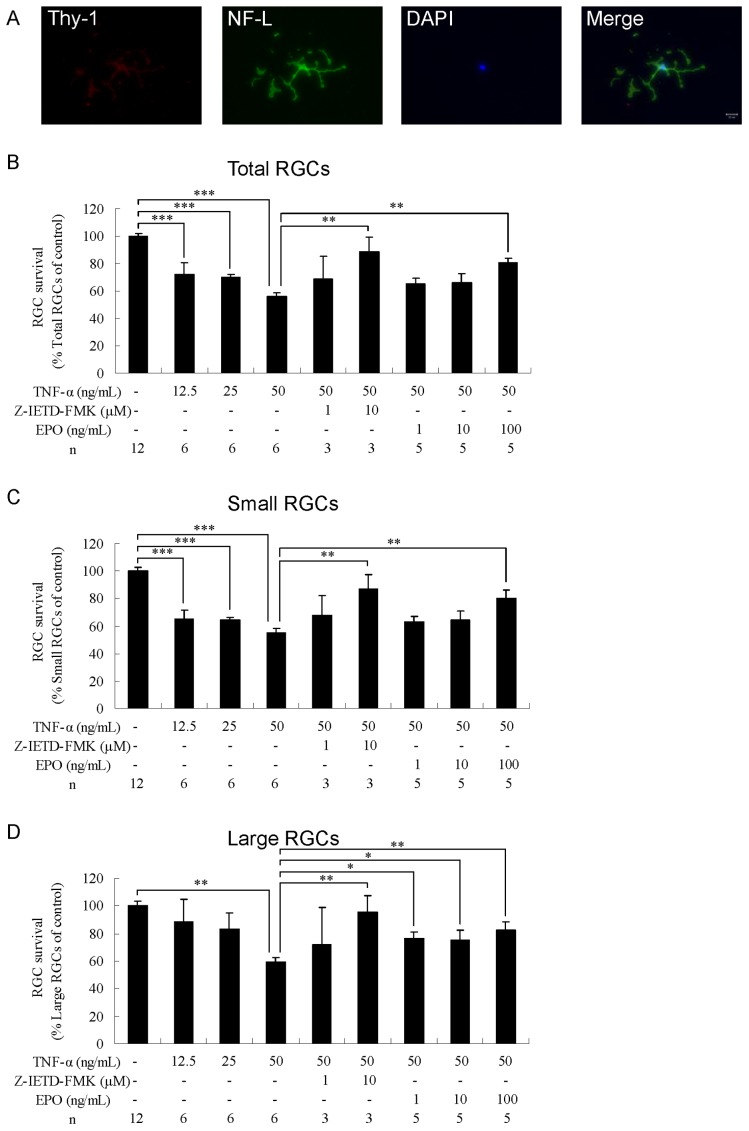
Effects of erythropoietin on total, small, and large RGCs under TNF-α-induced toxicity.(A) Morphology of TNF-α-treated RGCs. The cells were cultured in a medium supplemented with 50 ng/mL TNF-α. After culturing, RGCs were immunostained with anti-Thy-1 antibody (red), anti-NF-l antibody (green), and DAPI nuclear staining (blue). Survival rate of (B) total, (C) small, and (D) large RGCs. The cells were treated with a vehicle: TNF-α (12.5–50 ng/mL) alone, TNF-α (50 ng/mL)+Z-IETD-FMK (1 or 10 µM), or TNF-α (50 ng/mL)+EPO (1–100 ng/mL). The number of RGCs was counted and normalized versus the control group. Data are presented as mean ± standard error of the mean (n = 3–12). Data were statistically analyzed by 1-way ANOVA, followed by Dunnett’s test. *P<0.05, **P<0.01 and ***P<0.001.